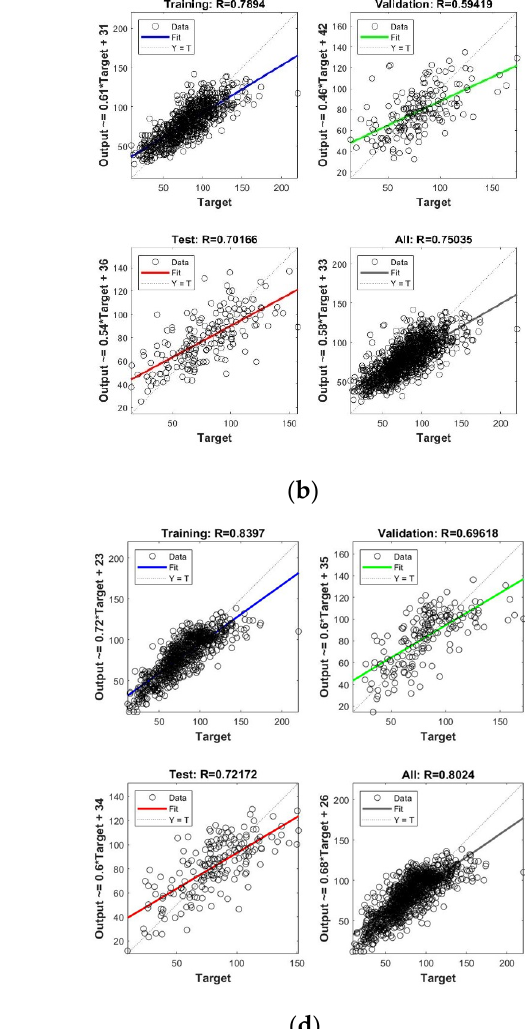
Figure 16. AGB inversion data processing process.